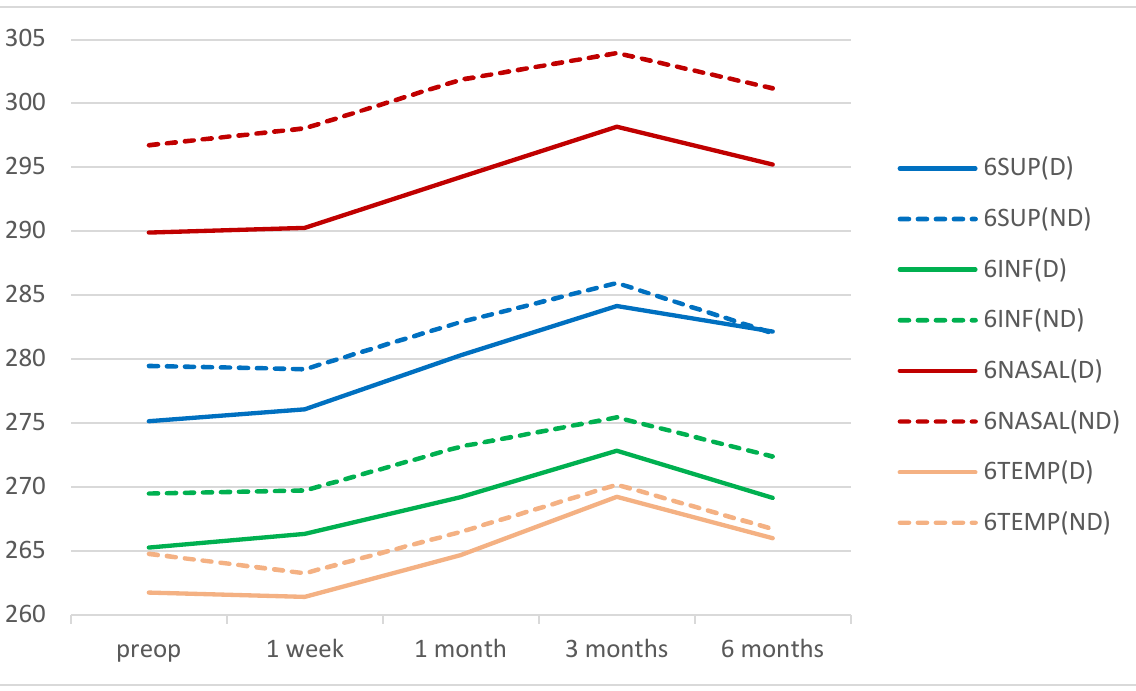
Figure 4. Mean values of the retinal thicknesses in the 6 mm ring of the ETDRS grid for DM patients and non-diabetic subjects during the follow-up time points. Values are expressed in microns. Analyzing gender as an influence factor, statistically significant differences were found in the central area of the ETDRS grid ( p = 0.035), with thicker values in men than in women. There were no differences in the other areas of the ETDRS. Data are shown in Figure